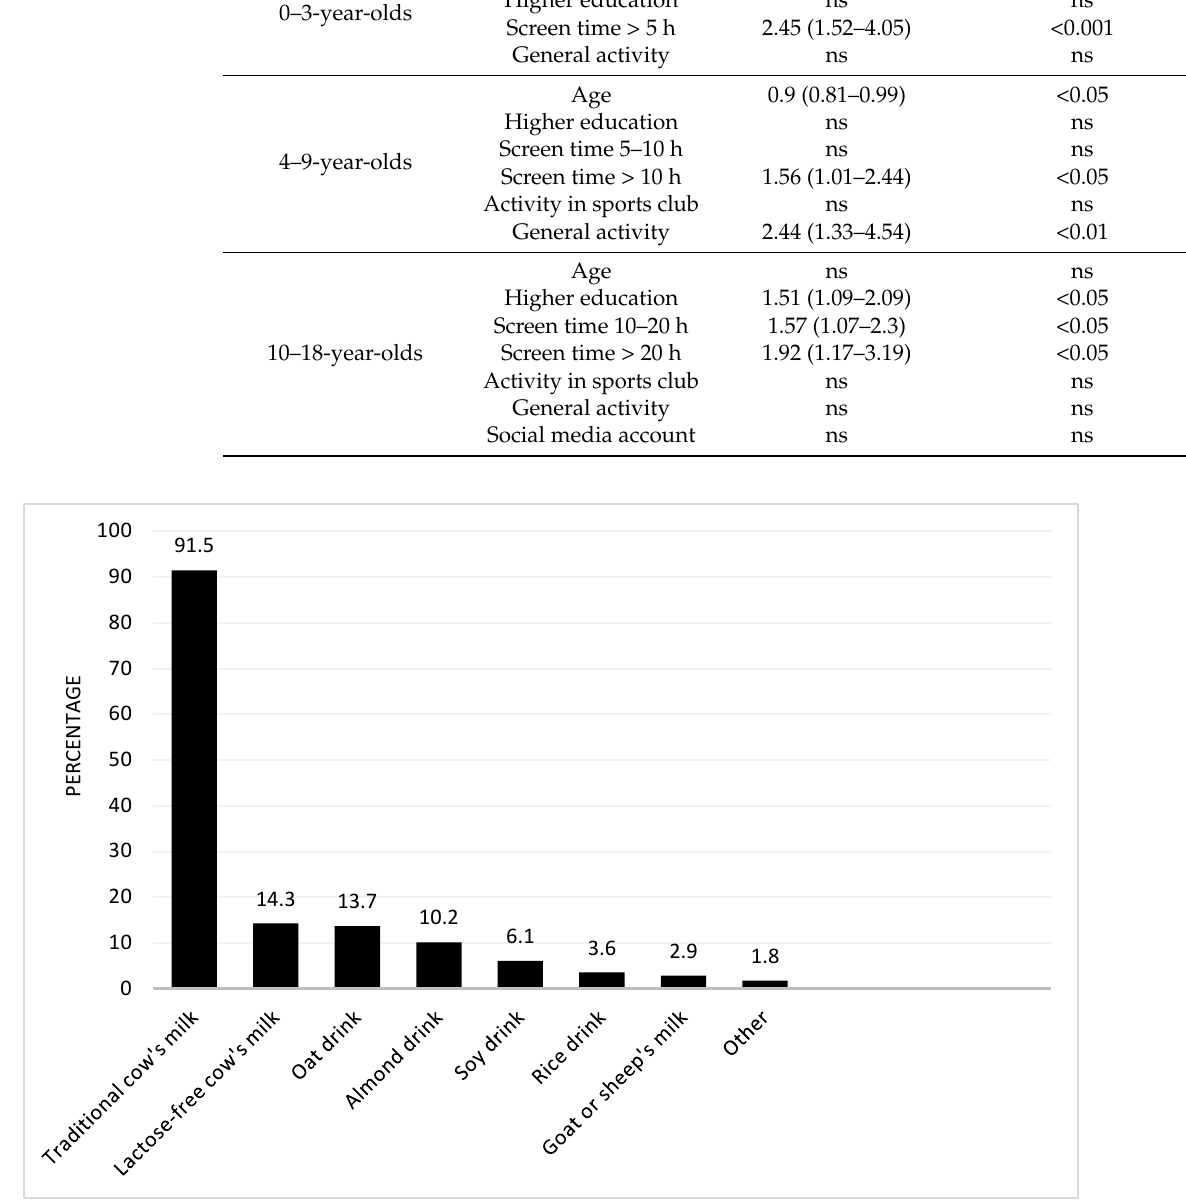
Figure 2. Milk or milk alternatives regularly consumed in the family. Other: coconut milk, raw cow’s milk, buffalo milk, millet drink, pea drink.